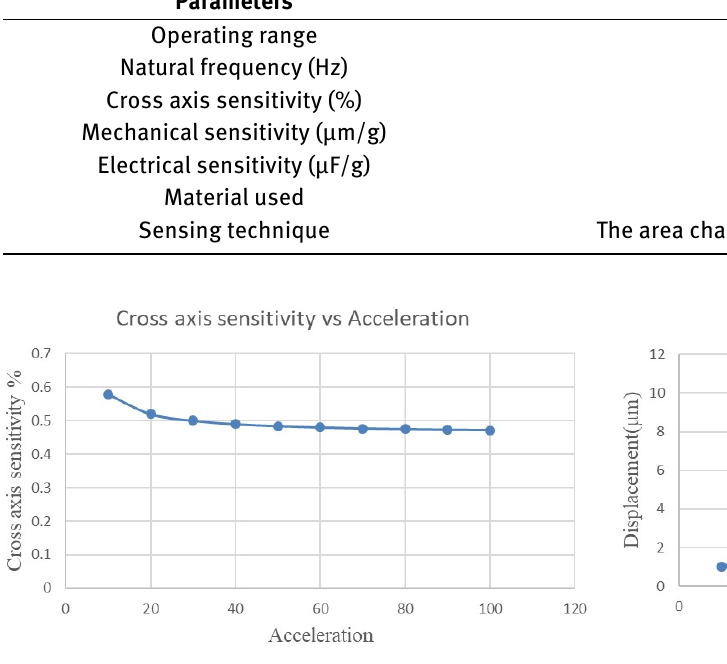
Figure 10: Cross axis sensitivity vs. acceleration Figure 11: Displacement vs.